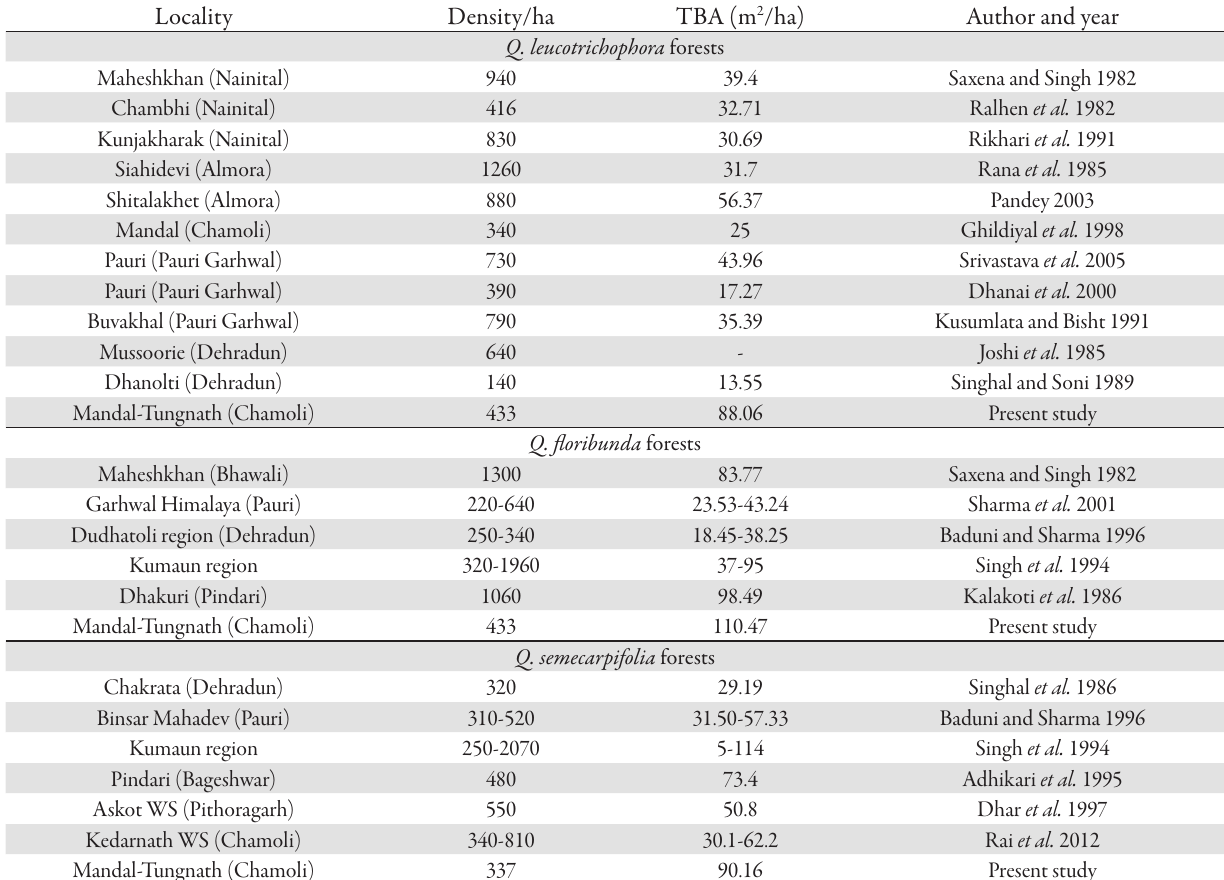
Tab. 5. Data on tree density and total basal area (TBA) of oak forest in the Uttarakhand